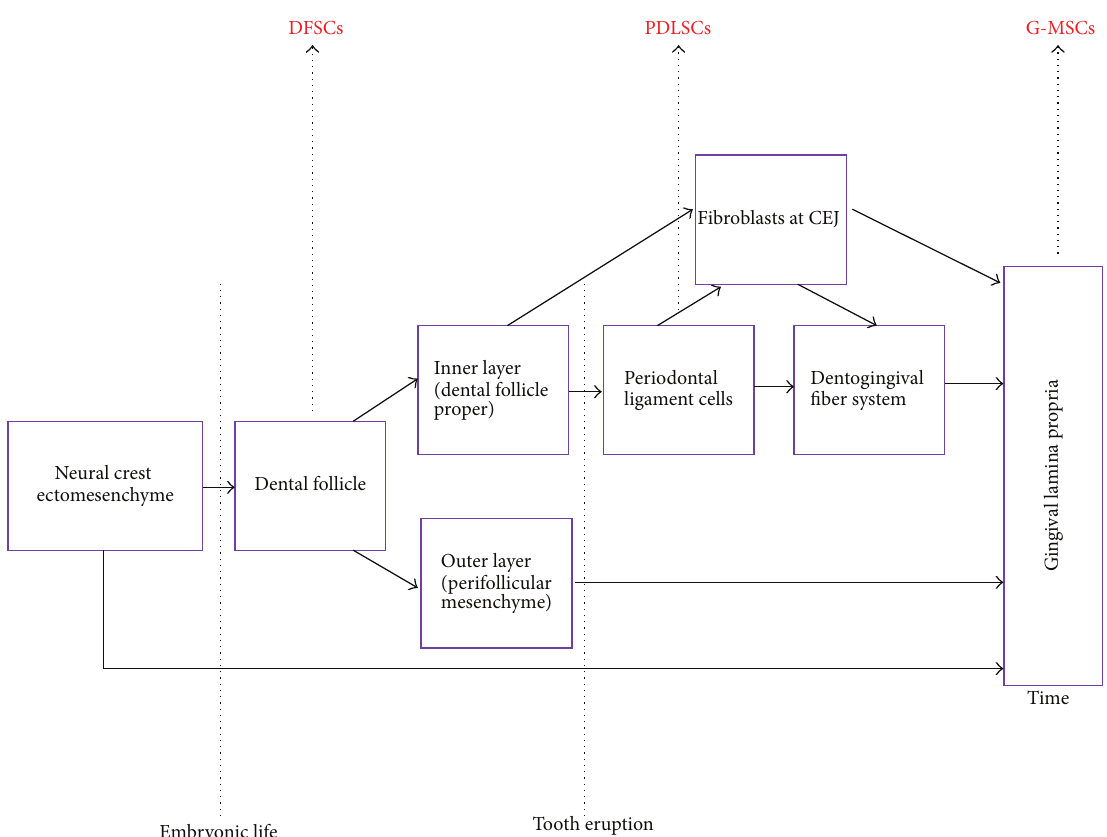
Figure 1: Schematic drawing of the oral tissues contributing to the developmental origin of human gingival lamina propria. DFSCs: dental follicle stem cells, G-MSCs: gingival mesenchymal stem/progenitor cells, PDLSCs: periodontal ligament stem